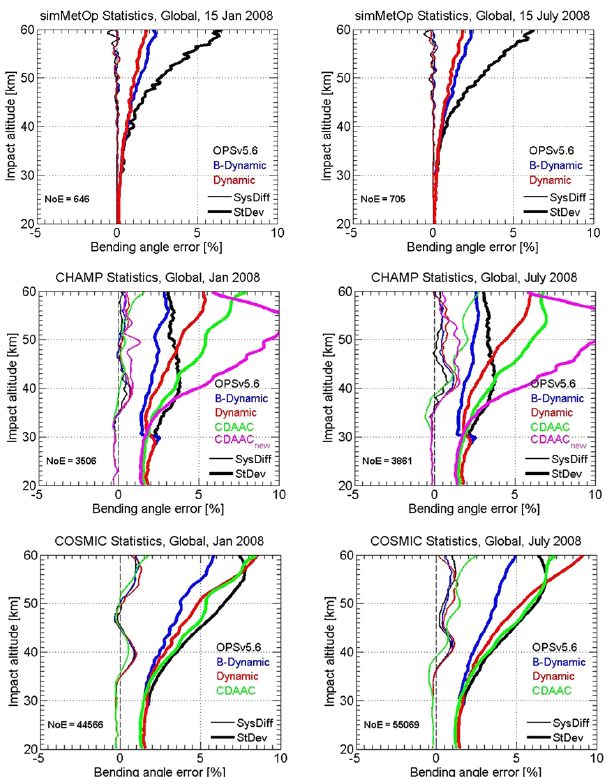
Figure 9. Systematic differences (SysDiff, light lines) and standard deviations (SD, heavy lines) of statistically optimized bending an- gles, relative to “perfect” simulated bending angles or co-located ECMWF analysis bending angles used as a reference, of the global ensemble of simMetOp events on 15 January and 15 July 2008 (up- per two panels), and of CHAMP and COSMIC events from the complete months of January and July 2008 (middle and bottom pan- els, respectively). Results from three different bias coverage factor choices in the dynamic algorithm – i.e., f bc = 1 (green), f bc = 5 (blue), and f bc = 1To15 (red) – as well as from the OPSv5.6 algo- rithm (black) are